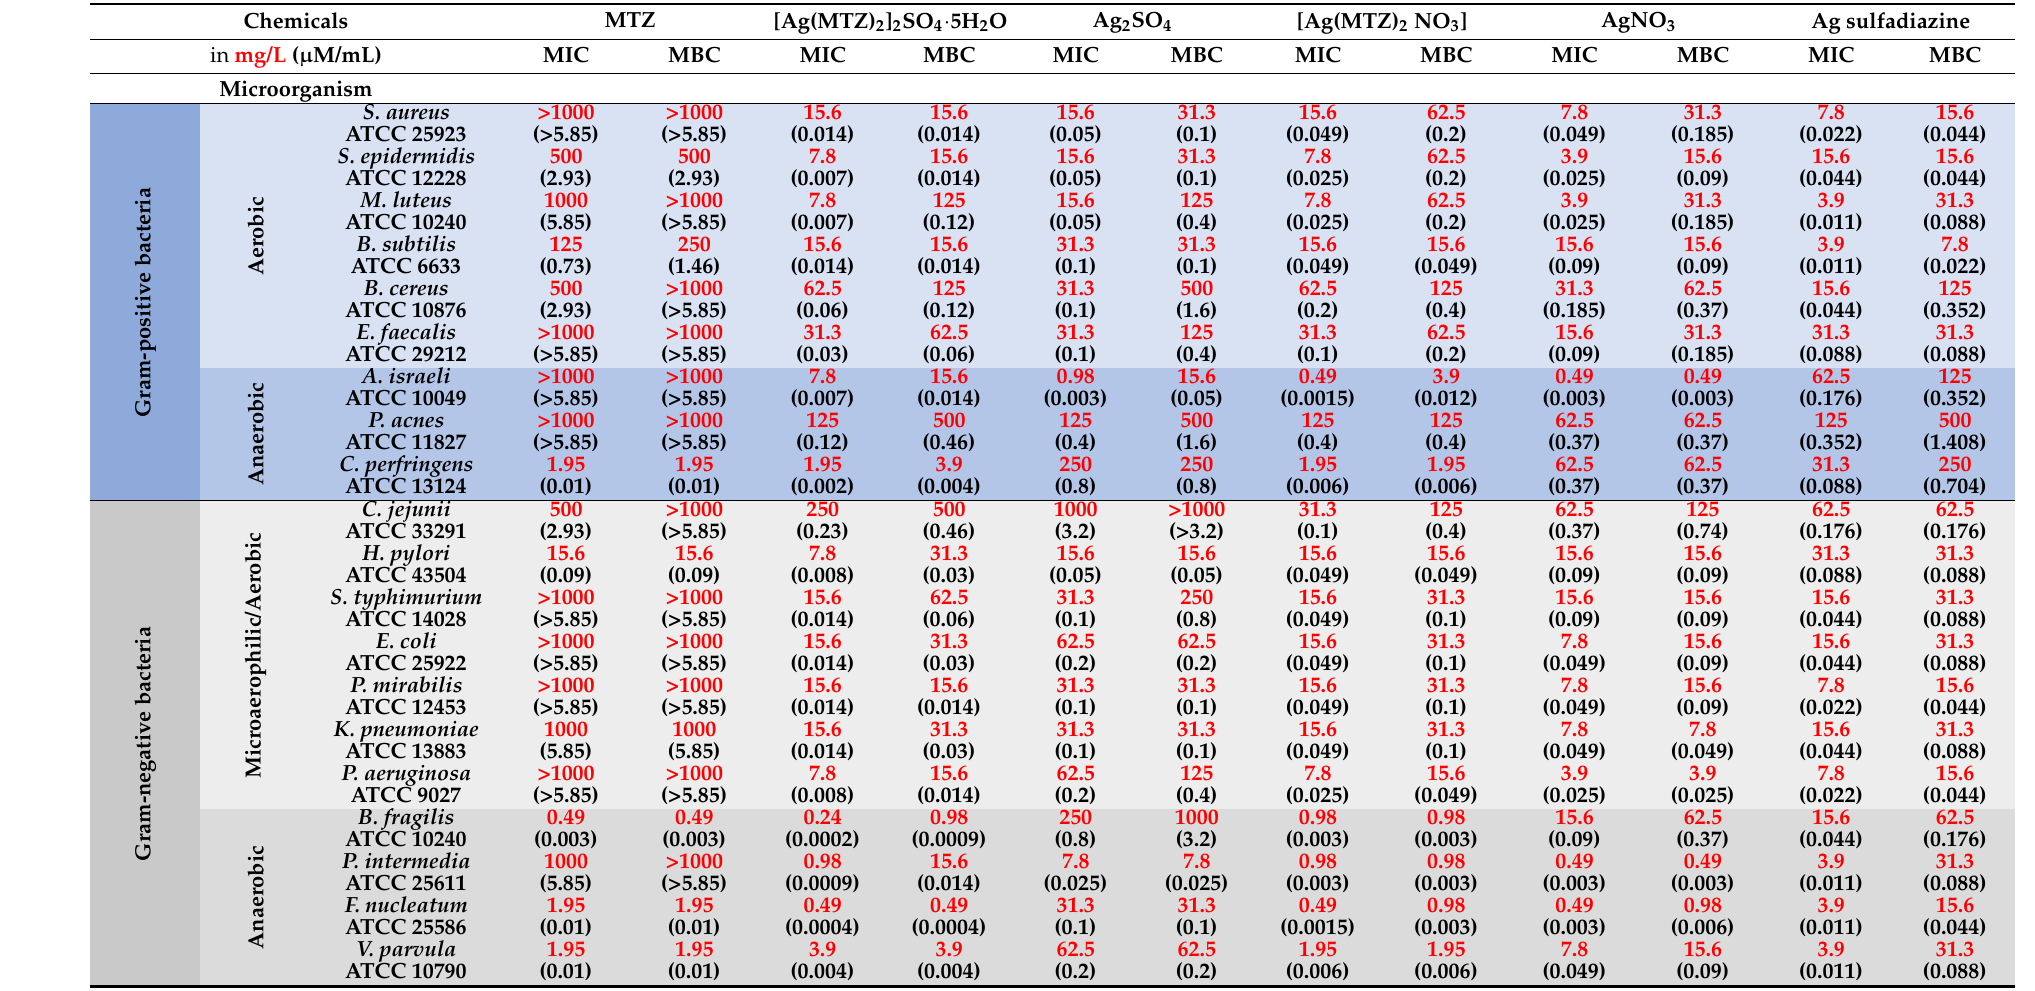
Table 4. Antimicrobial activity defined as minimal inhibitory concentration (MIC) and minimal bactericidal concentration (MBC) of silver(I) complexes and